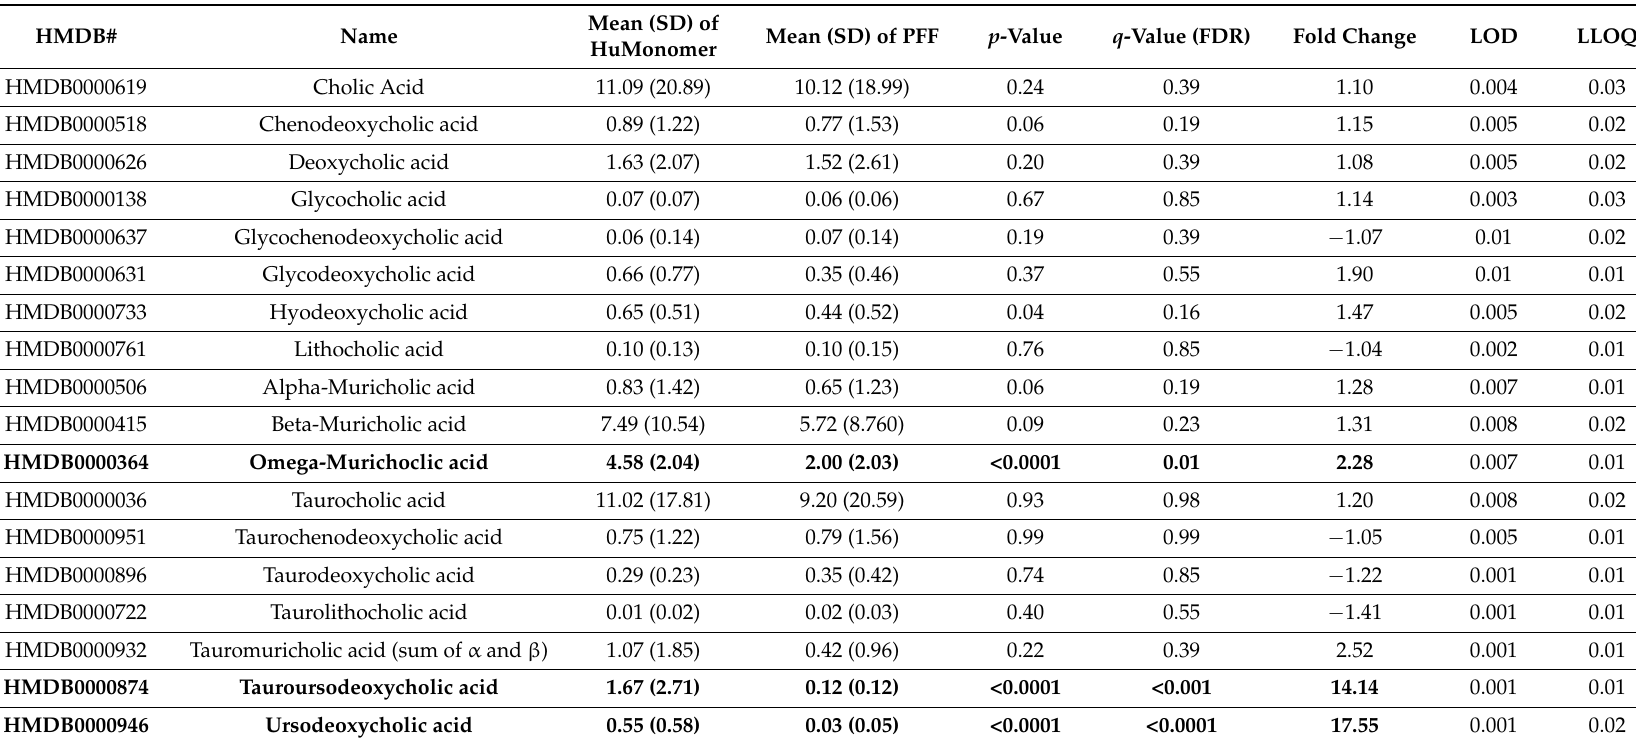
Table 1. Results of the univariate analyses for bile acids measured in serum from mice injected with HuMonomers and PFFs. p -Values were calculated using the Wilcoxon–Mann–Whitney test. LOD-Limit of detection; LLOQ-Lower limit of quantification. Those bile acids highlighted in bold are considered statistically significantly different ( p < 0.05; q <